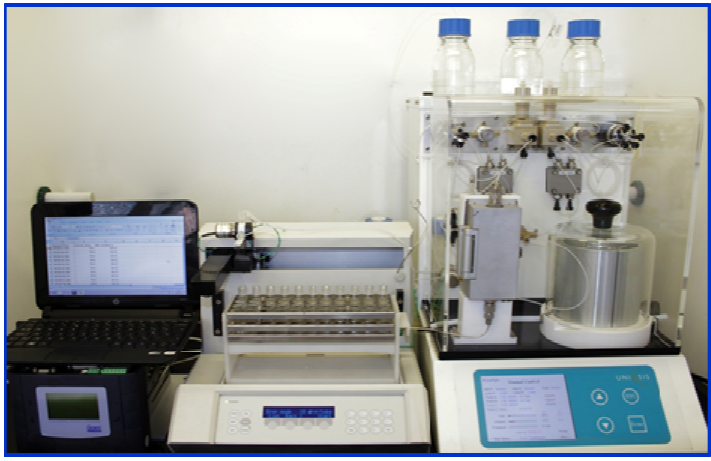
Figure 2. Continuous FlowSyn flow reactor experimental set-up.